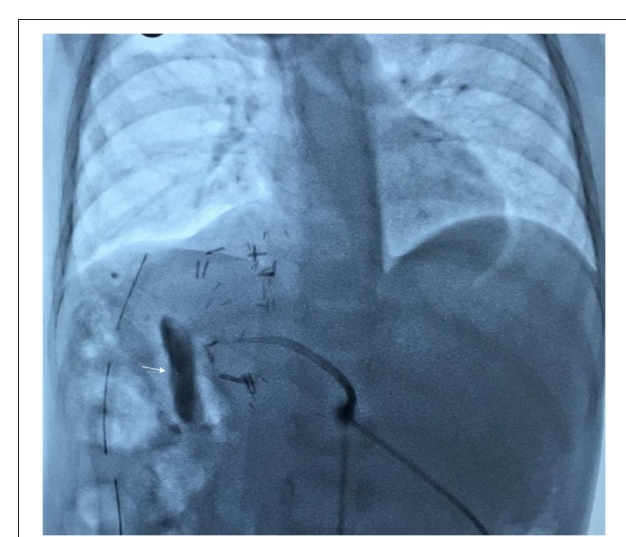
FIGURE 4 | Fluoroscopy image showing completed hepaticojejunostomy with internoexternal stent with contrast in the jejunal limb (arrow). hepaticojejunostomy was challenging in the present case in view of the adhesions at the porta due to surgery, bile leak and surrounding inflammation combined with the small